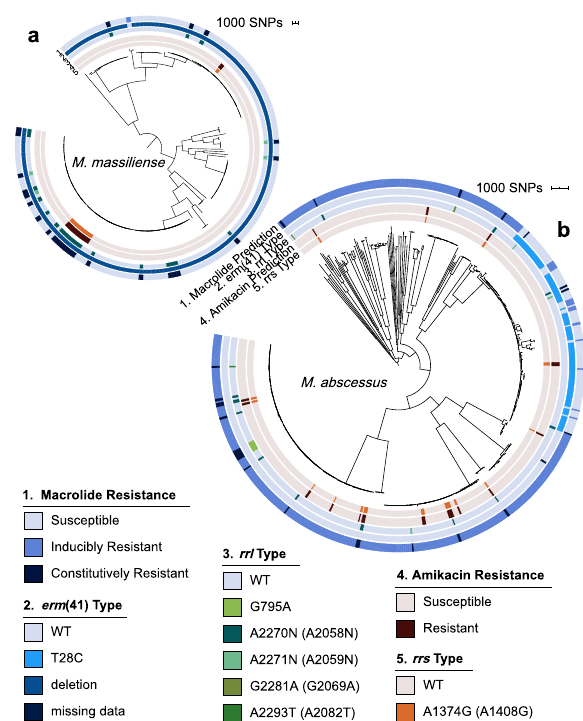
Fig. 3 Predicted phenotypic resistance to clarithromycin and amikacin in MAB is subspecies speci fi c. Predicted resistance in a M. massiliense and b M. abscessus to clarithromycin. From outside to inside, the rings represent: (1) predicted macrolide resistance, based on genotypic resistance markers in erm (41) and rrl . (2) erm(41) variants which confer susceptibility to clarithromycin. Wild-type erm (41) in the absence of rrl SNPs is associated